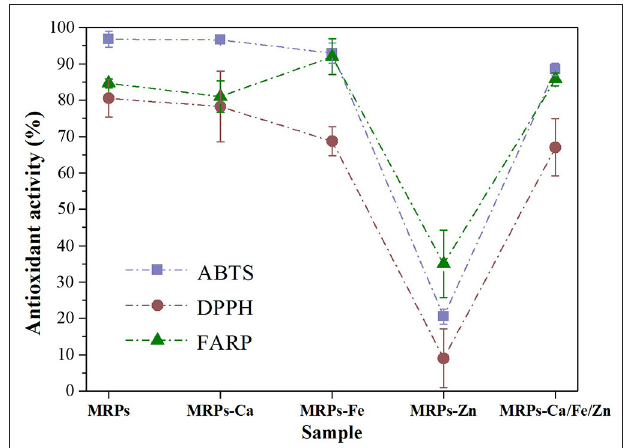
FIGURE 7 | Antioxidative activity analysis of MRPs, MRPs–Ca, MRPs–Fe, MRPs–Zn, and